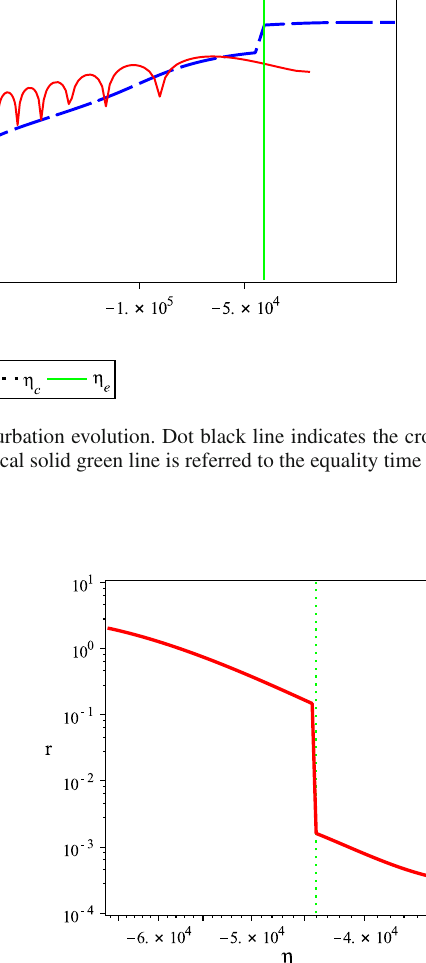
Fig. 6 The evolution of tensor to scalar ratio ( r ) versus η for the case contained term H 4 . The ratio at η e suddenly decreased to r ≤ 0 .